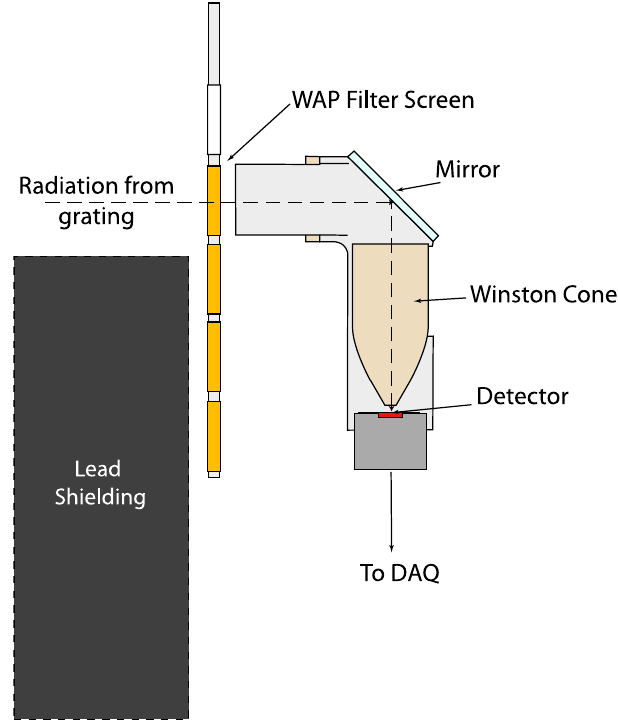
FIG. 5. (Color) Schematic of the detector-Winston cone arrange-